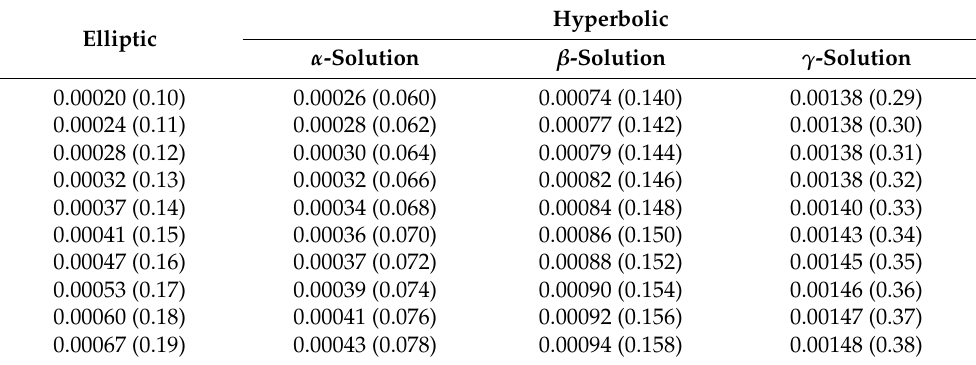
√ Table 3. The MSE of local regression method with l = 1 and bandwidth h (presented in parenthesis) in estimating the critical collapse response function g ( z ) = arg f 0 ( z ) in elliptic and hyperbolic cases based on a training sample of size n =